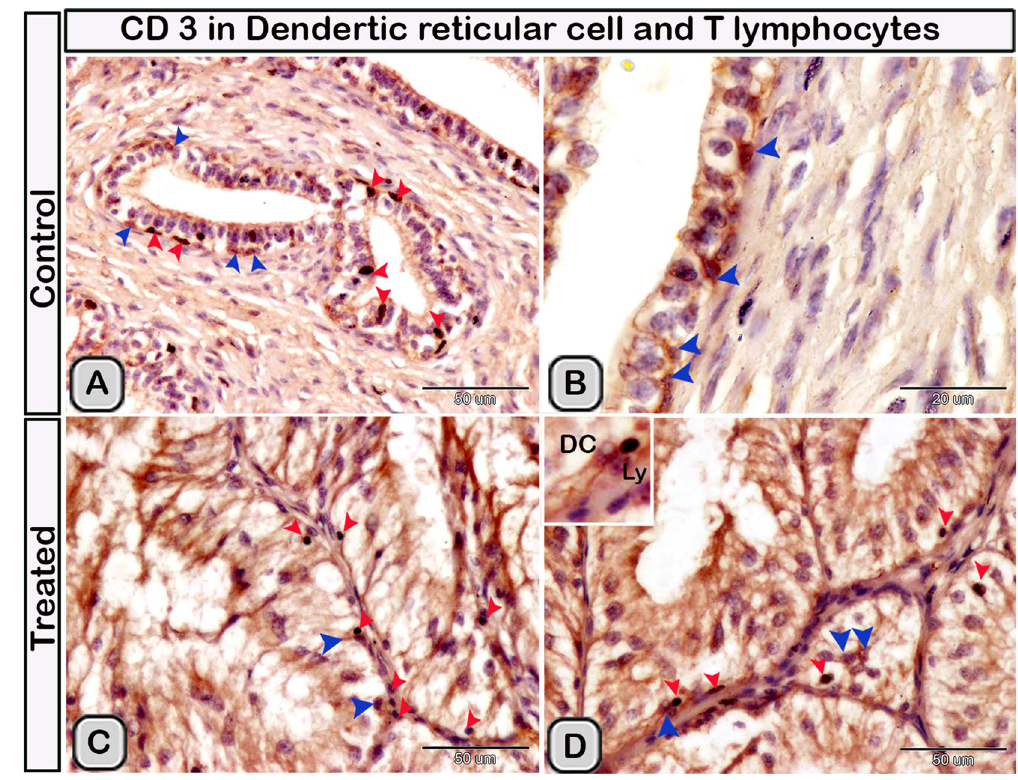
Figure 5. The effect of melatonin administration on the expression of CD3 in the dendritic cells (DC) and T-lymphocytes (Ly). (A,B) CD3 expressed in the DCs with its well defined processes (red arrowheads) and T-Lymphocytes (blue arrowheads) in the control groups. (C,D) The immunoreactivity for CD3 was more abundant in melatonin treated